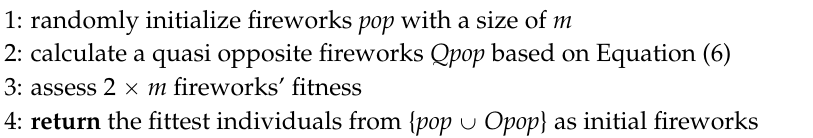
Algorithm 4 Opposition-Based Population Initialization